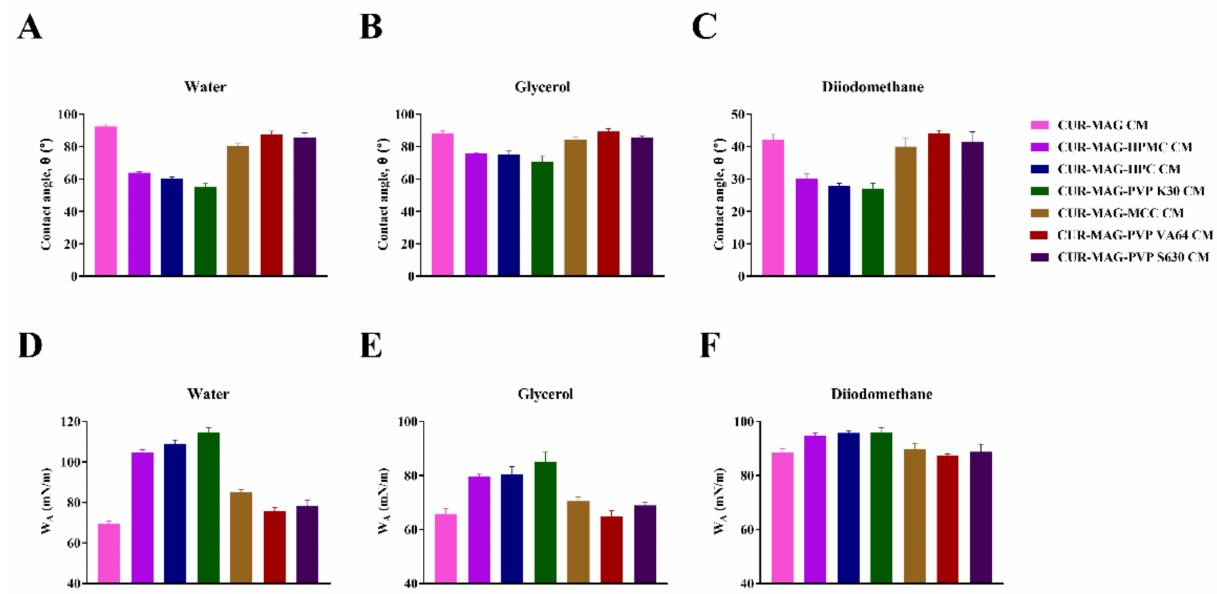
Figure 8. The contact angle ( θ ) of co-amorphous samples using ( A ) water, ( B ) glycerol and ( C ) diiodomethane. The work of the liquid adhesion to solid surface (W A ) of co-amorphous samples using ( D ) water, ( E ) glycerol and ( F )